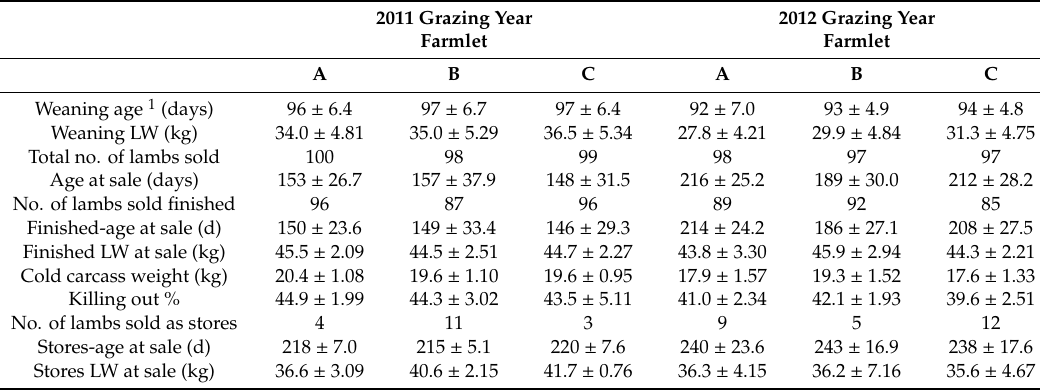
Table 8. Live weights (LW) and sales data for twin lambs in 2011 and 2012 grazing years (100 lambs per farmlet each